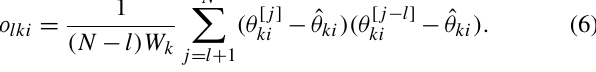
its effects on correlations between samples but noting that the algorithm remains computationally